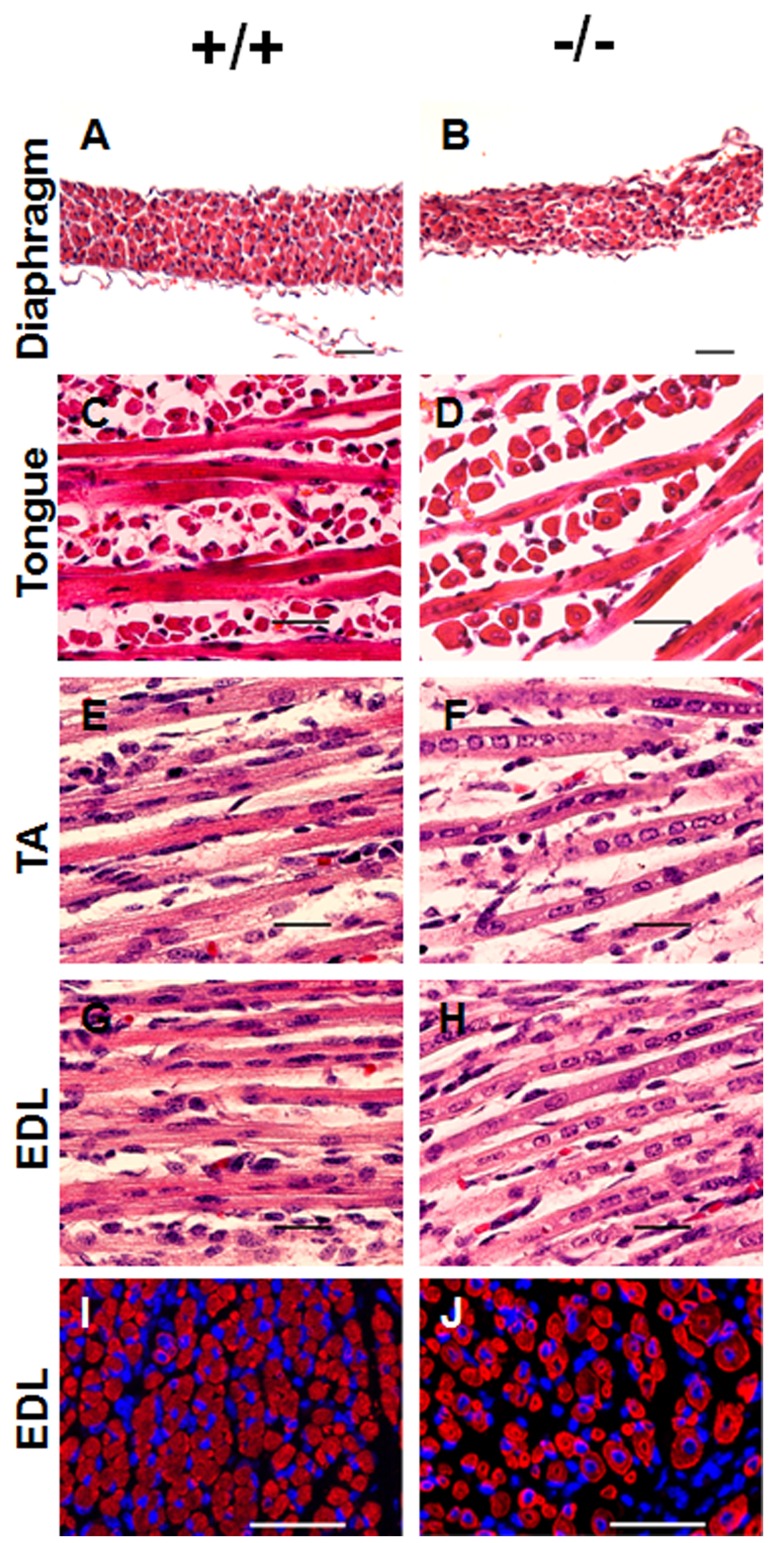
Histological analyses of skeletal muscles in newborn Stac3 homozygous mutant mice (−/−) and wild-type (+/+) littermates.
A–H, Hematoxylin and eosin staining of diaphragm, tongue, tibialis anterior (TA), and extensor digitorum longus (EDL) muscles. Note the difference in the location of myonuclei between the two genotypes. I and J, Immunohistochemical staining of EDL muscle for myosin heavy chain protein (red) and nuclei (blue). Shown are representative images taken from matched areas. Scale bars  = 50 μm for micrographs A, B, I, and J. Scale bars  = 25 μm for micrographs C-H.